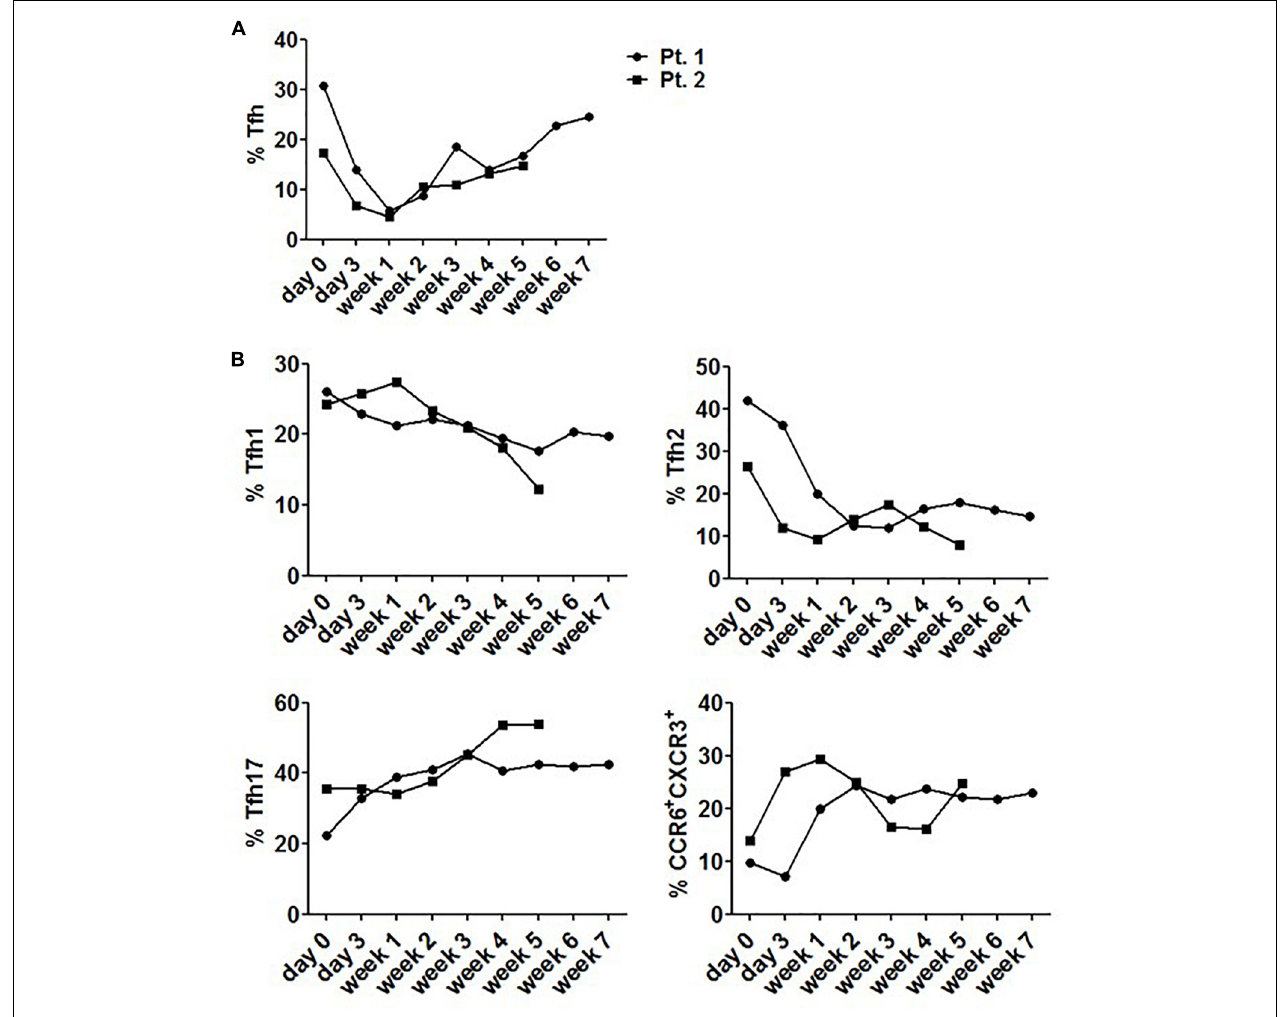
FIGURE 7 | Changes of circulating Tfh cells in SLE patients receiving corticosteroid therapy. (A) The level of circulating Tfh cells from 2 newly diagnosed SLE patients fluctuated with 6–8 week steroid therapy period. (B) The level of circulating Tfh subsets from 2 newly diagnosed SLE patients fluctuated with 6–8 week steroid therapy period. All results are presented as mean ± standard error of the mean